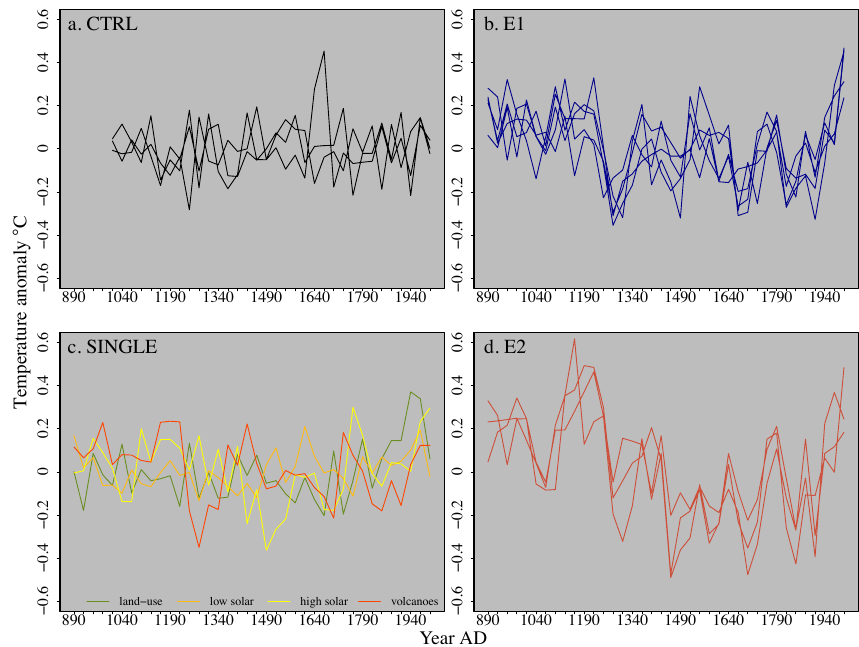
Fig. 1. The MPI Millennium Activity COSMOS simulations over the last millennium with 30-yr non-overlapping means of global land-only annual temperature anomalies ( ◦ C) from the period 850–2000. The simulations are shown as the CTRLs (top-left panel), E1 ensemble (top- right panel), SINGLE forcing (bottom-left panel) and E2 ensemble (bottom-right panel). The SINGLE forcing simulation series are land-use changes (green), low solar (light orange), high solar (yellow) and volcanoes